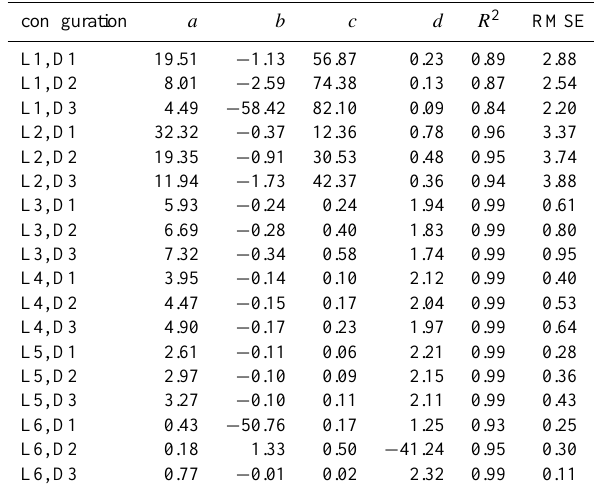
Table 2. Parameters and quality measures for the intersection prob- ability fits (Eq. 10) depending on lot or septic systems densities, respectively, (L1–L5) and drainfield sizes (D1, D2, D3). For spec- ifications of lot and drainfield sizes, please refer to Sect. 4.5. R